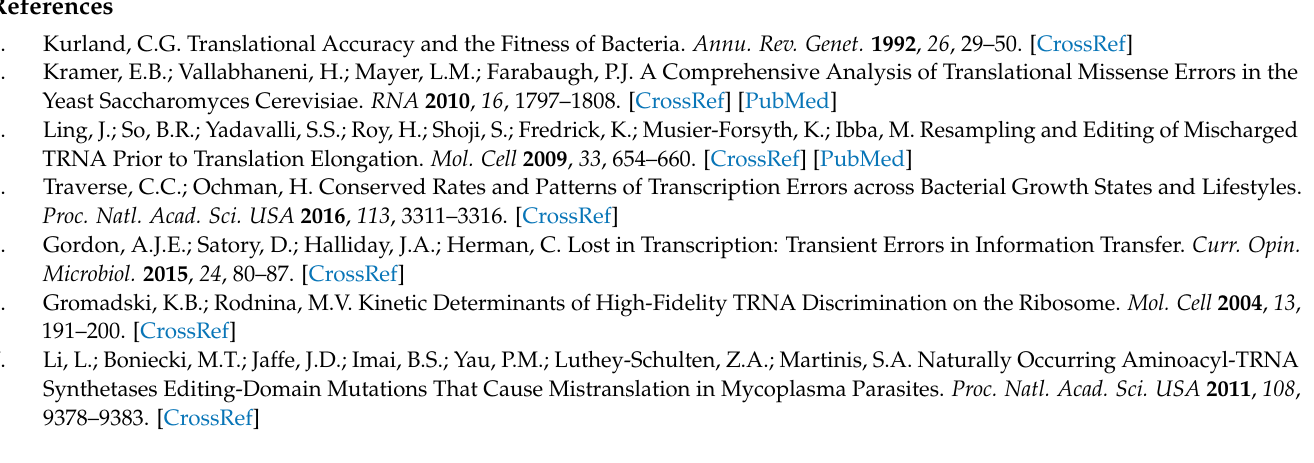
cholate. Figure S2: Growth curves of Salmonella strains. Table S1: Oligonucleotides used in this